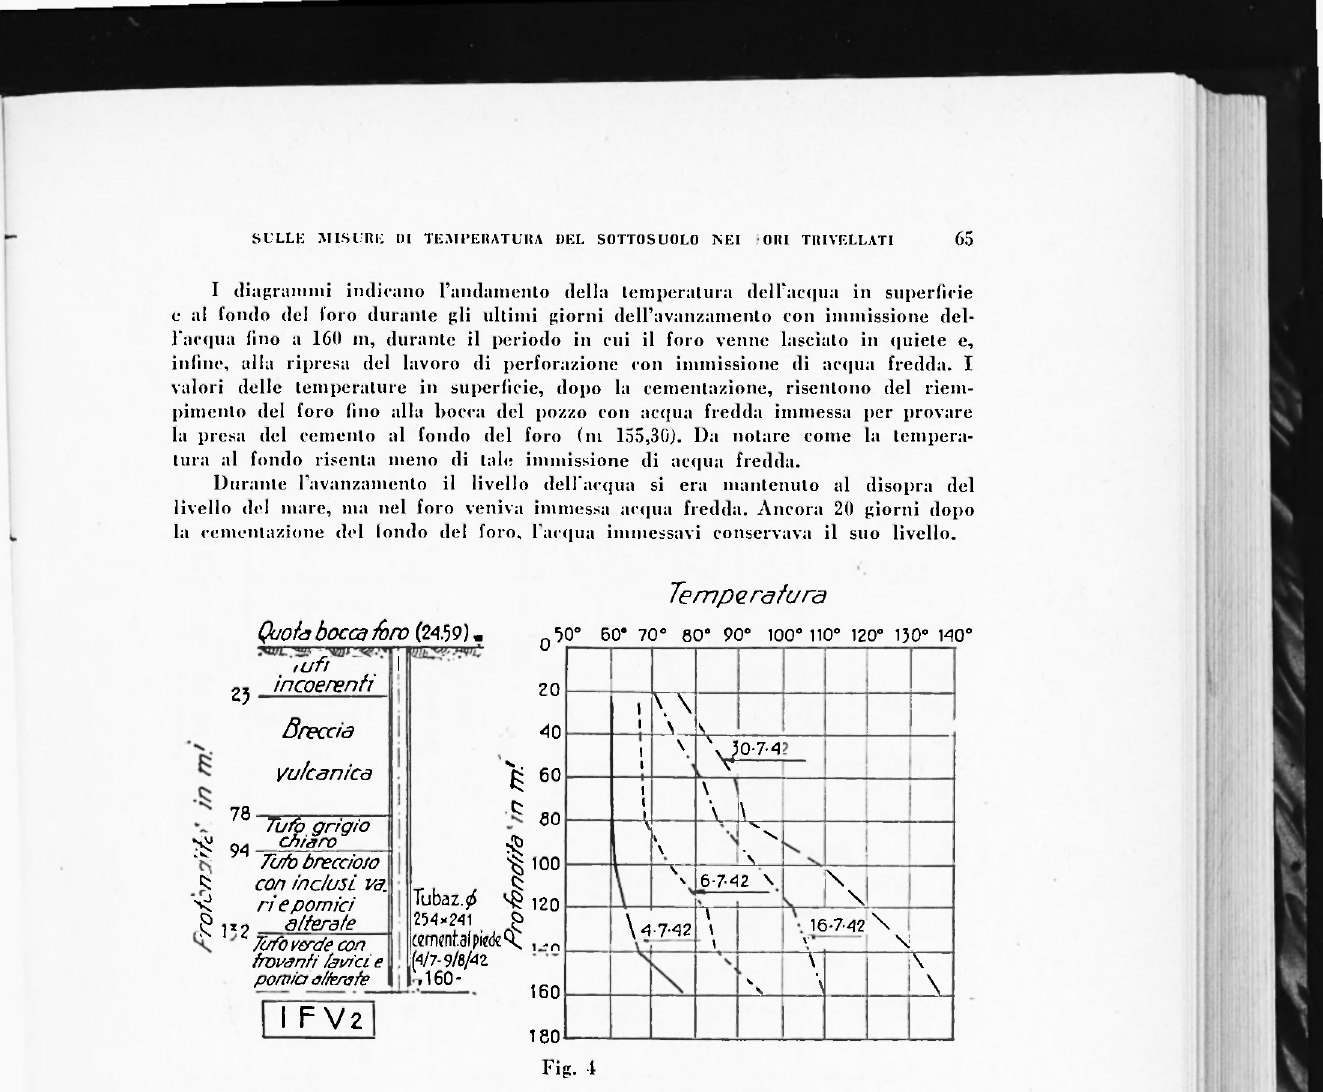
Fig. 4 • Foro IFV2, profondo m 160. Distribuzione della temperatura lungo la ver- ticale del foro.